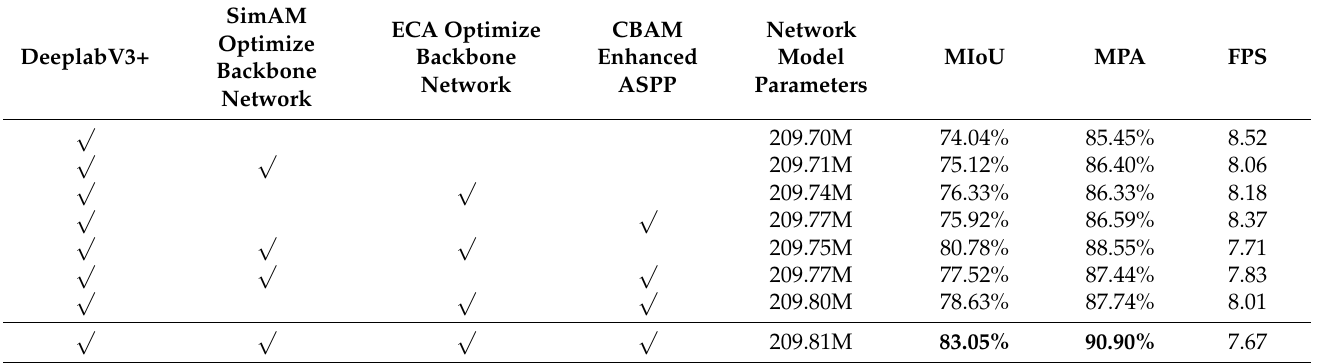
Table 2. Ablation experiments were performed by adding an attention